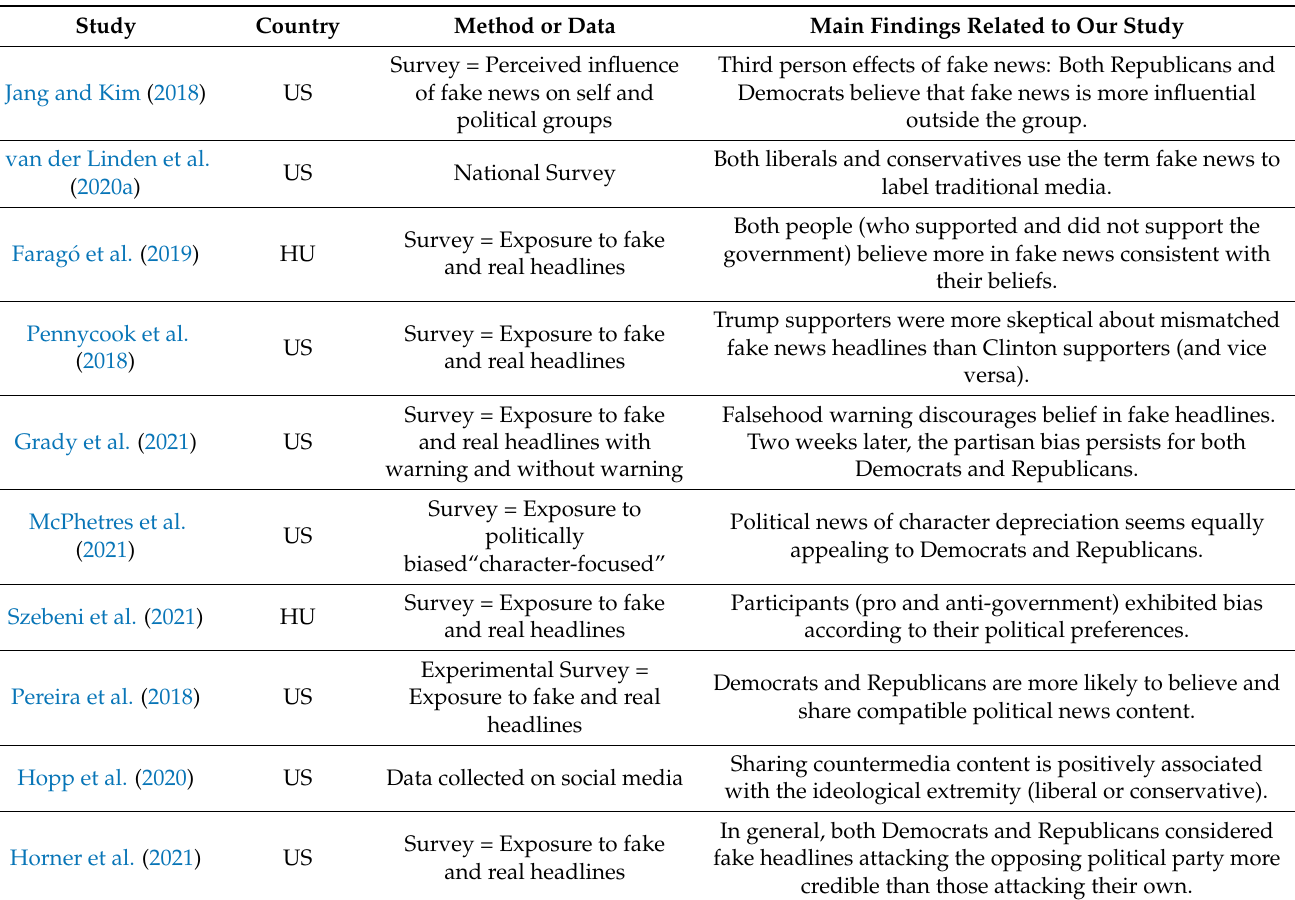
Table 2. Political symmetry in the discernment of fake news